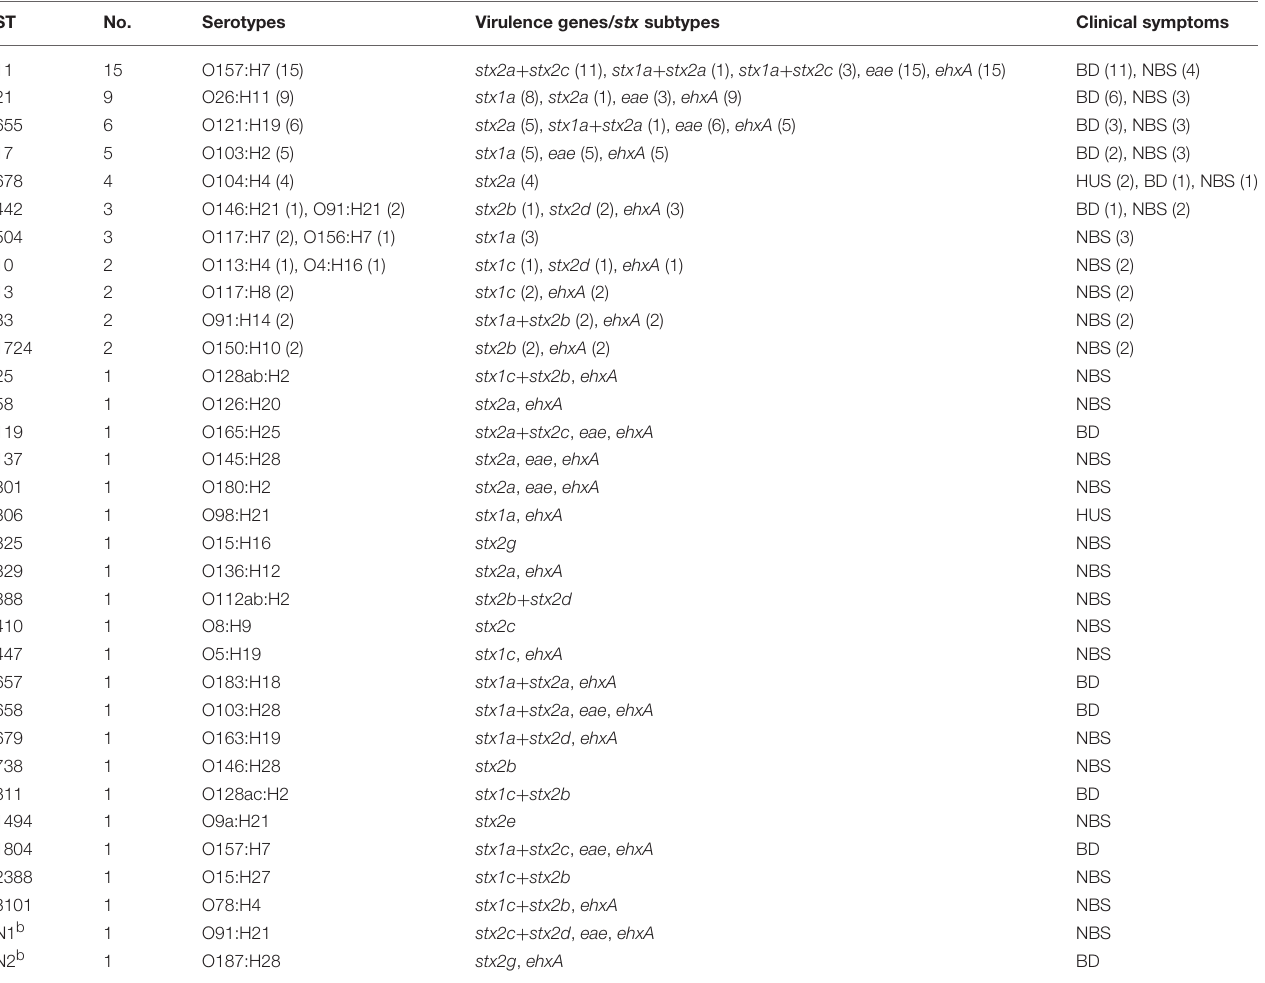
TABLE 4 | Sequence types, serotypes, virulence genes in 75 STEC isolates and associated-clinical symptoms a . ST No. Serotypes Virulence genes/ stx subtypes Clinical